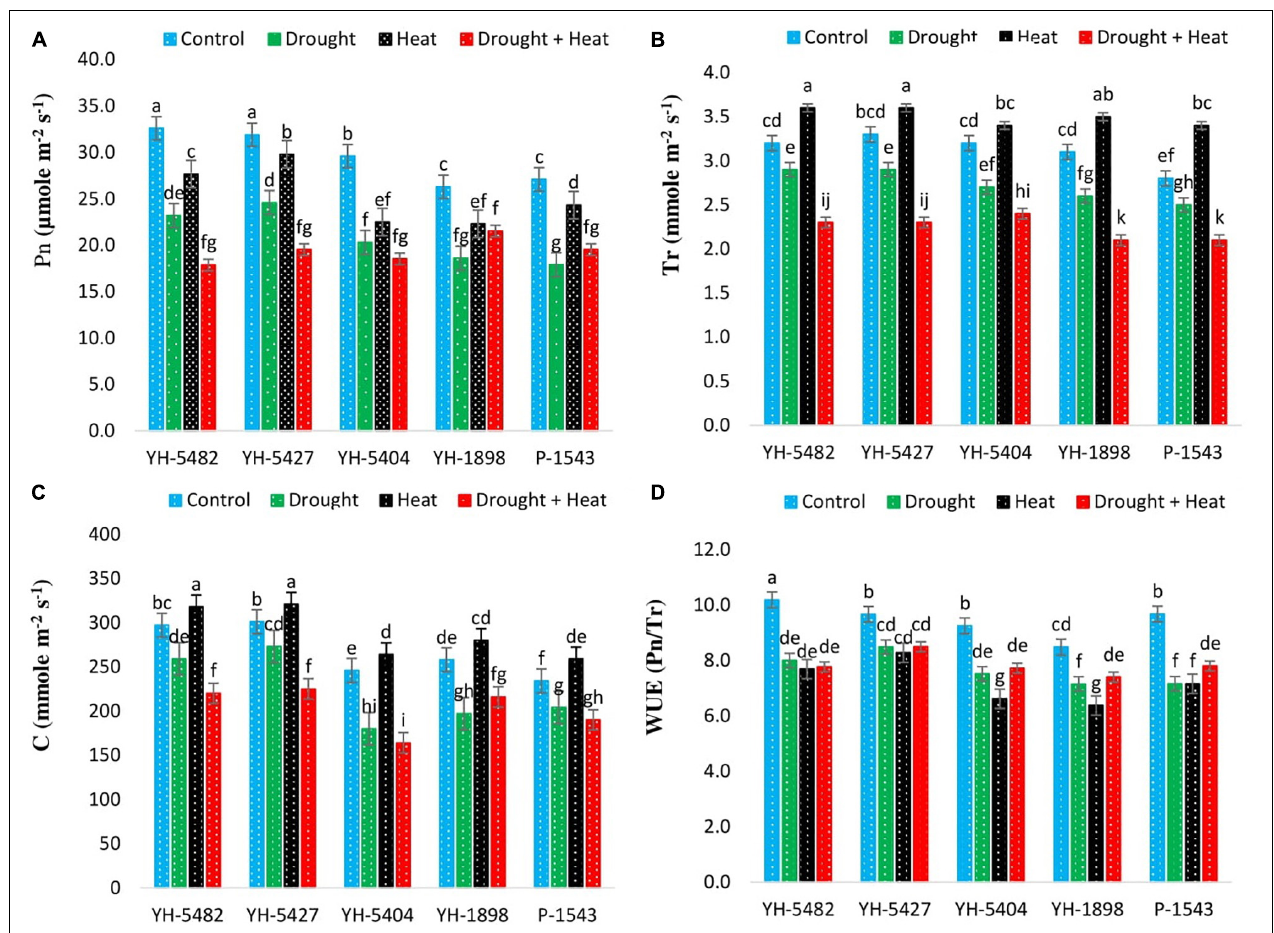
FIGURE 4 | Effect of heat, drought, and heat +drought stresses on (A) Net Photosynthetic rate (B) Transpirational rate (C) Stomatal Conductance, and (D) Water use efficiency in five maize hybrids. Capped bars above means represent the ± SE of three replicates.